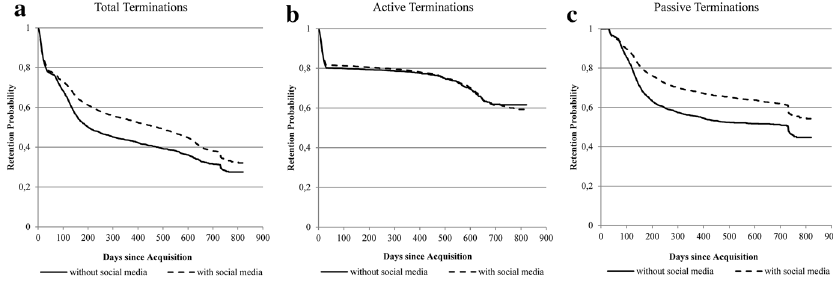
Fig. 1 Kaplan–Meier survival estimates